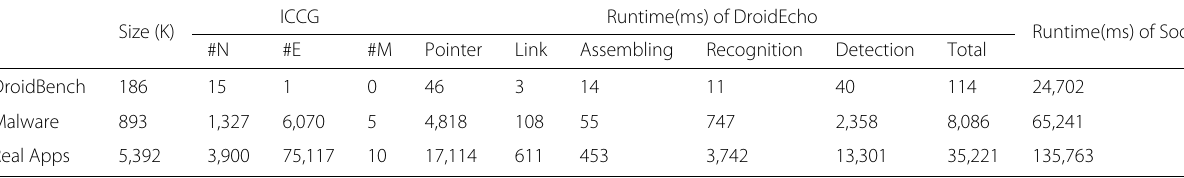
Runtime(ms) of Soot